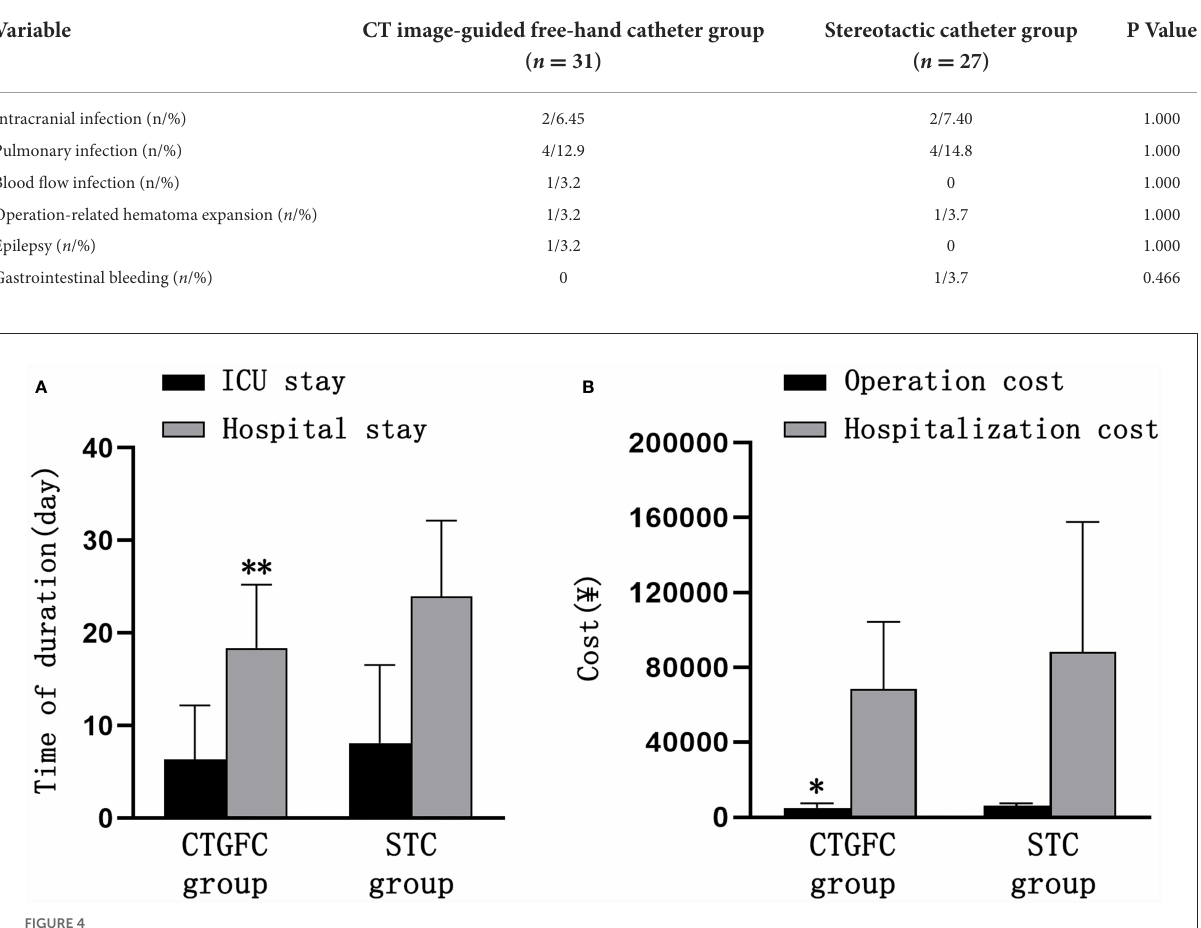
TABLE 2 Comparison of postoperative complications between the two groups.